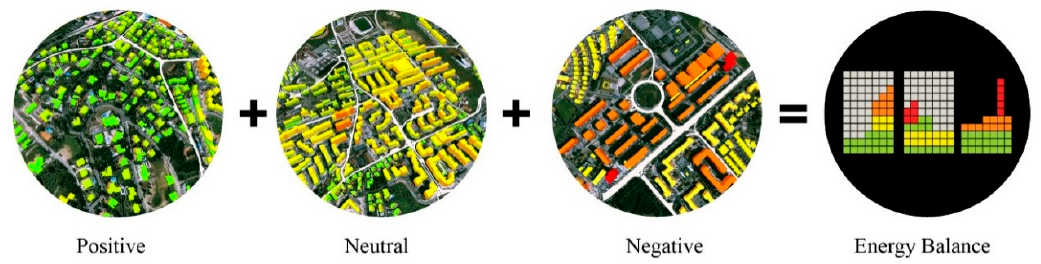
Figure 1. Geographical Urban Units Delimitation (GUUD) model: cellular approach concept.